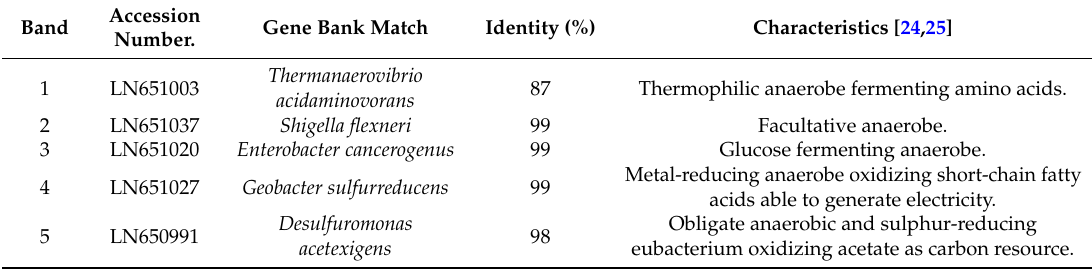
Table 2. 16S rDNA denaturing gradient gel electrophoresis (DGGE) gene band identification and characterization of the bacterial